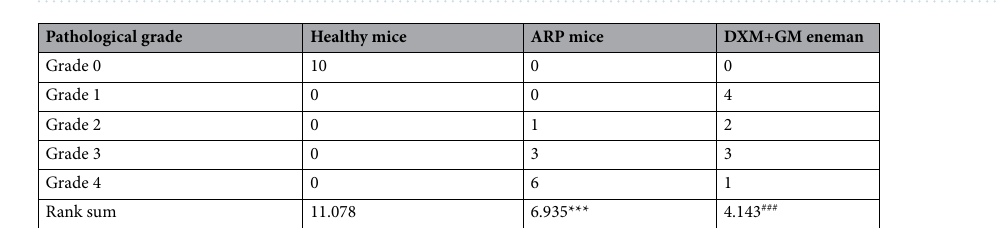
Table 1. The pathological grade of rectal tissue of mice Compared to healthy mice, *** P < 0.001, compared to ARP mice, ### P < 0.001, Rank-Sum test. DXM + GM enema alleviates pathological damage and decreases pathological grade of ARP mice. The rank sum test was used for the evaluation of pathological grade. The pathological grade of ARP mice was increased compared with healthy control group mice (*** P < 0.001). DXM + GM enema alleviated pathological damage and reduced pathological grade of ARP mice ( ### P < 0.001).